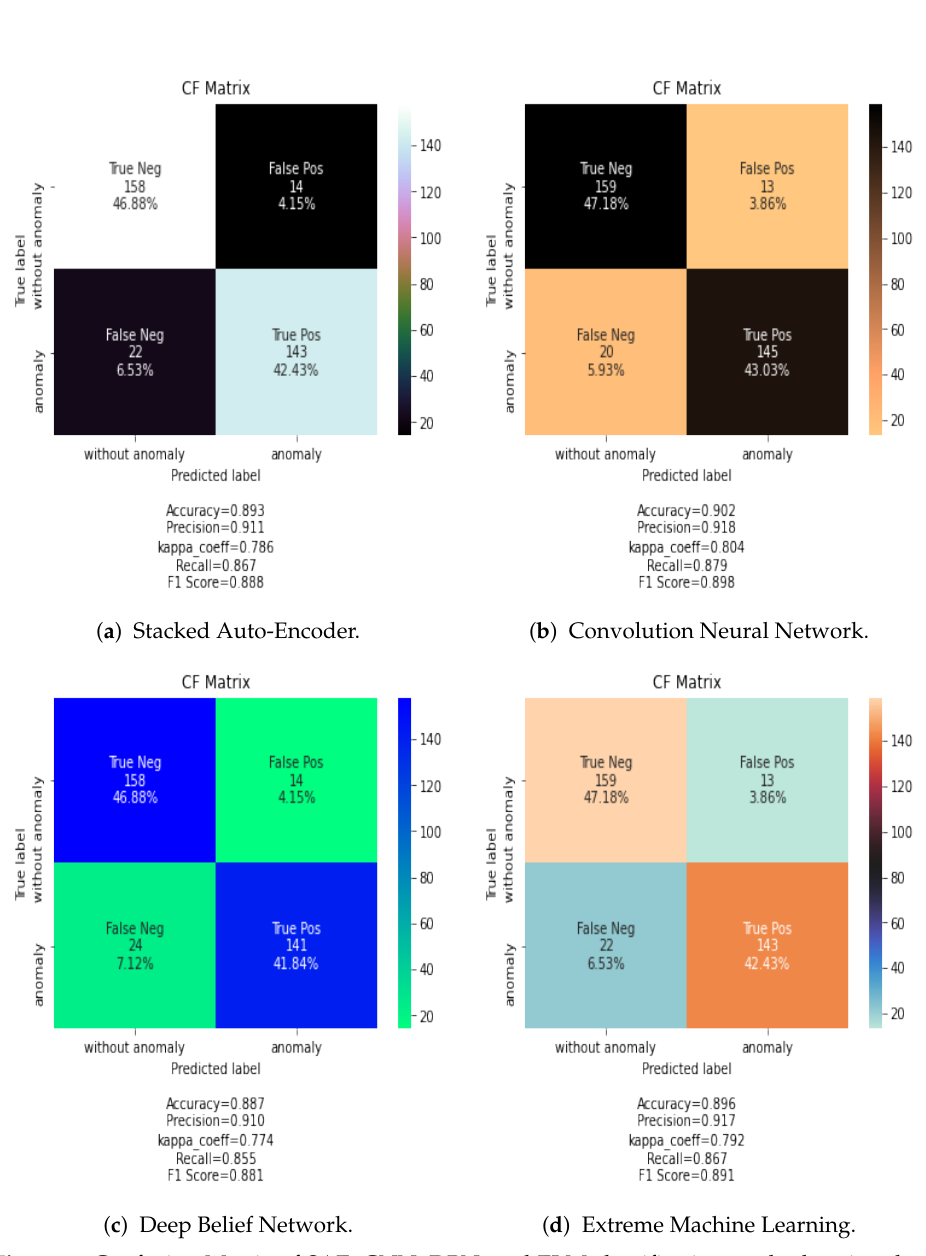
Figure 7. Confusion Matrix of SAE, CNN, DBN, and ELM classification methods using the PCA fusion